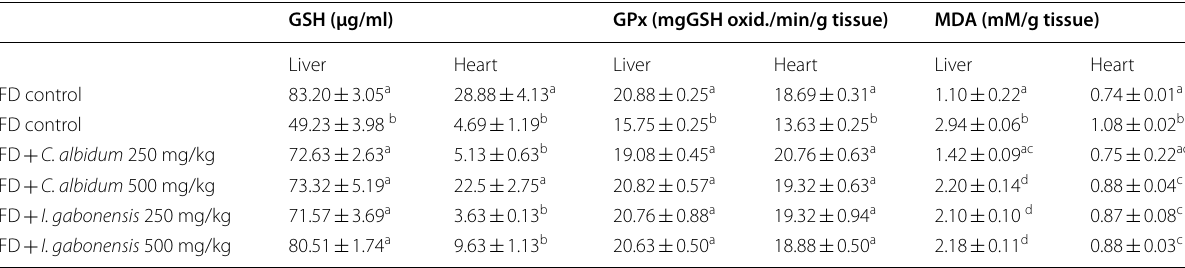
a, b, c, d These lower case letters a, b, c and d are different levels of significance at p < 0.05. a is significantly different from b and c, and vice versa. b is also significantly different from c and vice versa. The use of such alphabets is to show the homogenous sets which would bear same alphabet so that the different sets can easily